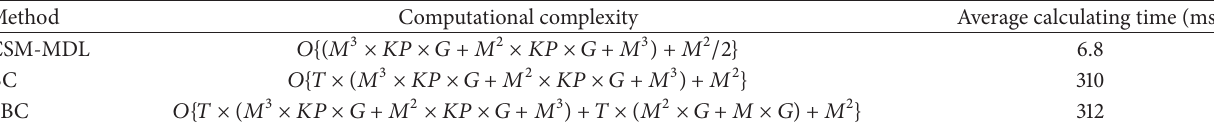
Table 1: Average calculating time of the four methods.